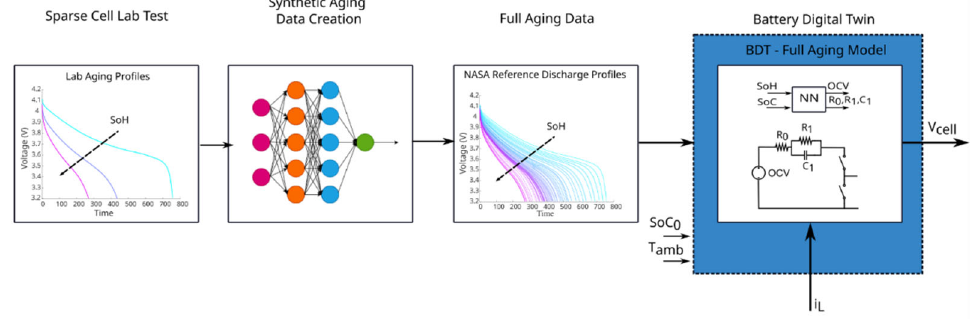
Figure 9. Concept of CAM BDT.